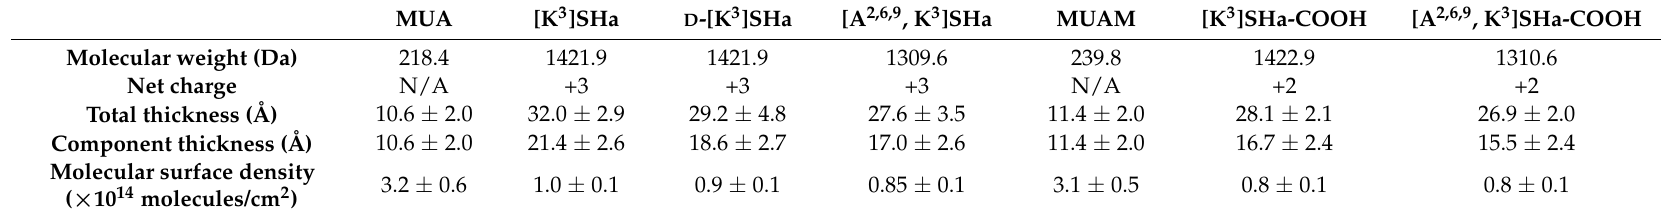
Table 3. Peptide and surface physicochemical properties. The molecular weight and the net charge of unbound peptides are indicated. The estimated thickness and molecular surface density of the thiol and thiol-temporin layers were calculated using XPS